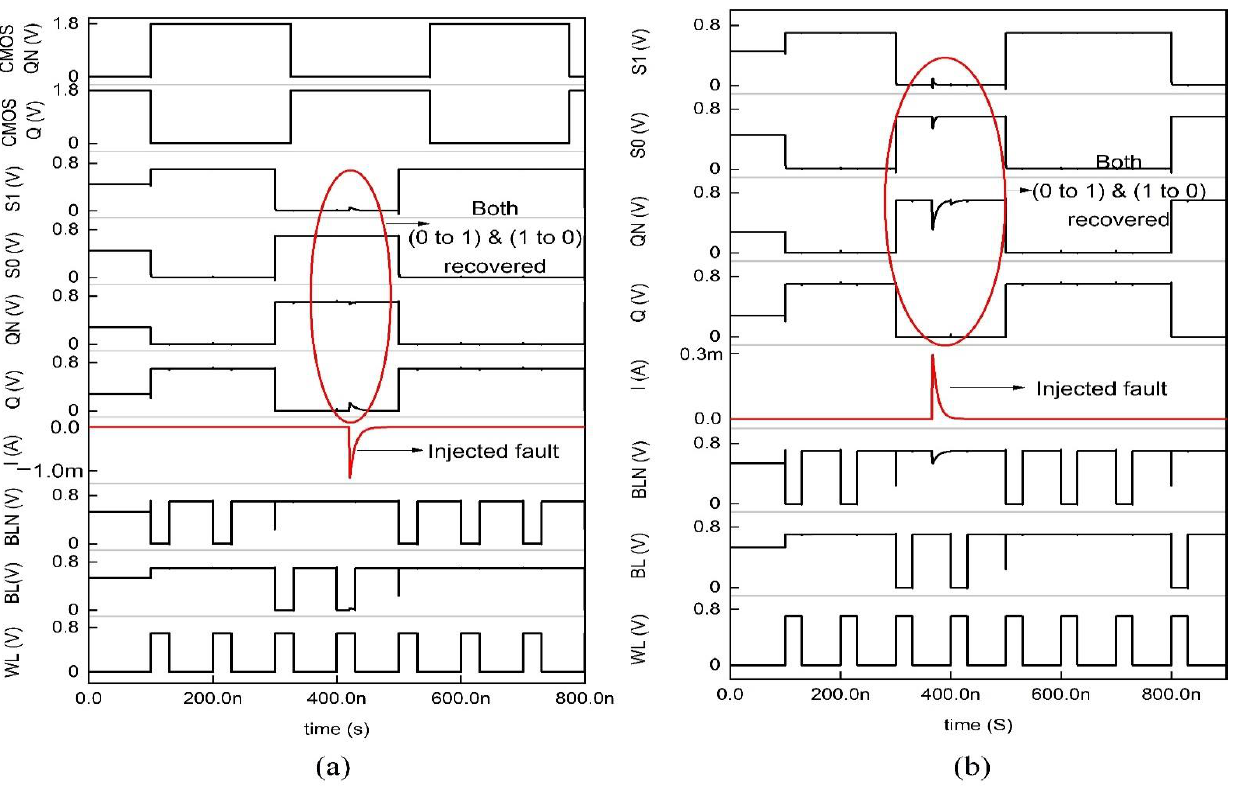
Figure 11. Timing and simulation of the 10T memory cell where the fault is injected at node Q and QN is shown in ( a , b ).